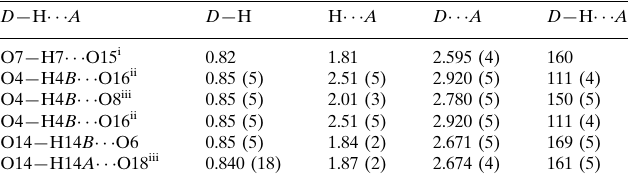
Hydrogen-bond geometry (A˚ , (cid:2)